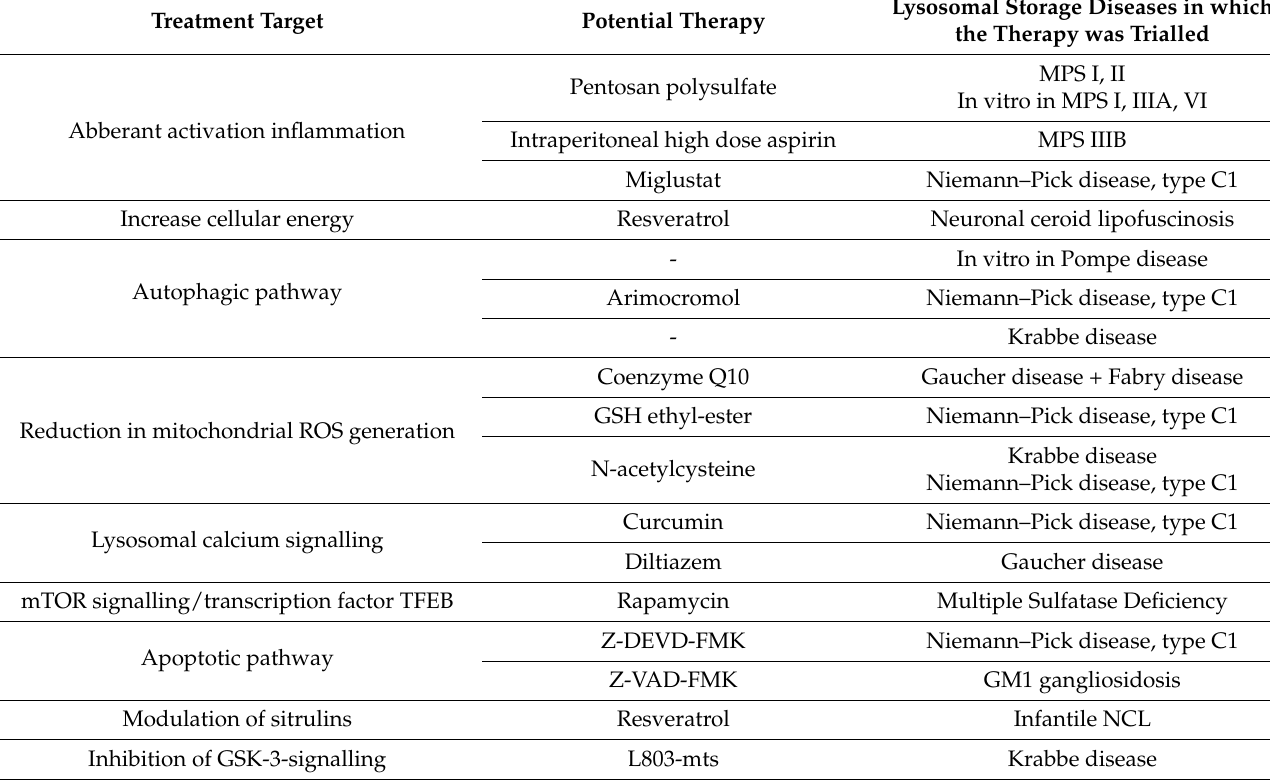
Table 2. Treatment target and therapies trialed in vivo or in